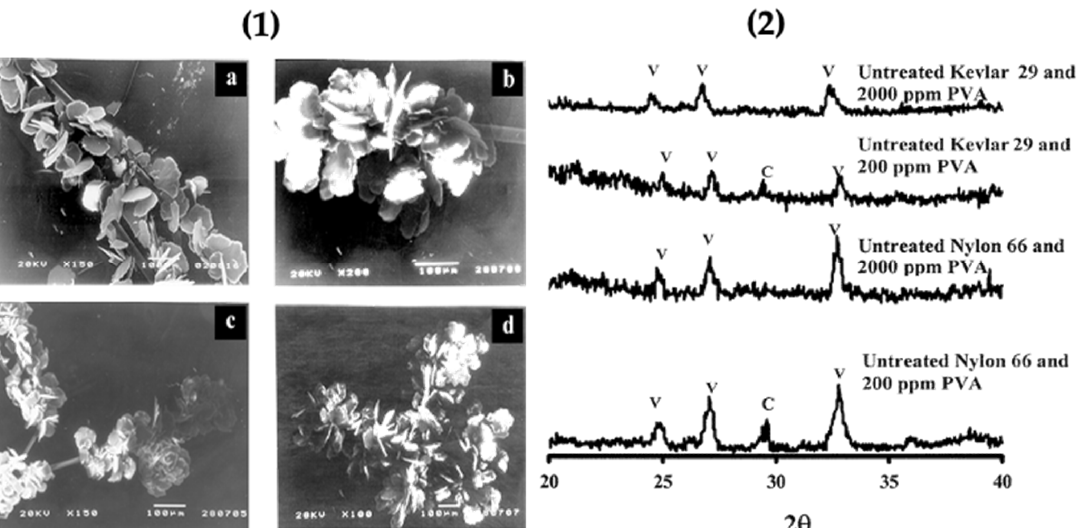
Figure 18. ( 1 ) Representative SEM images of the vaterite phase grown on untreated Nylon 66 in the presence of 200 ppm ( a ) and 2000 ppm PVA ( b ); untreated Kevlar 29 in the presence of 200 ppm ( c ) and 2000 ppm PVA ( d ); and ( 2 ) Representative powder XRD patterns of the calcium carbonate pol- ymorphs formed on untreated fibres in the presence of PVA. The diffraction peaks that correspond to calcite and vaterite phases are indicated by C and V, respectively. Taken with permission from reference [69].